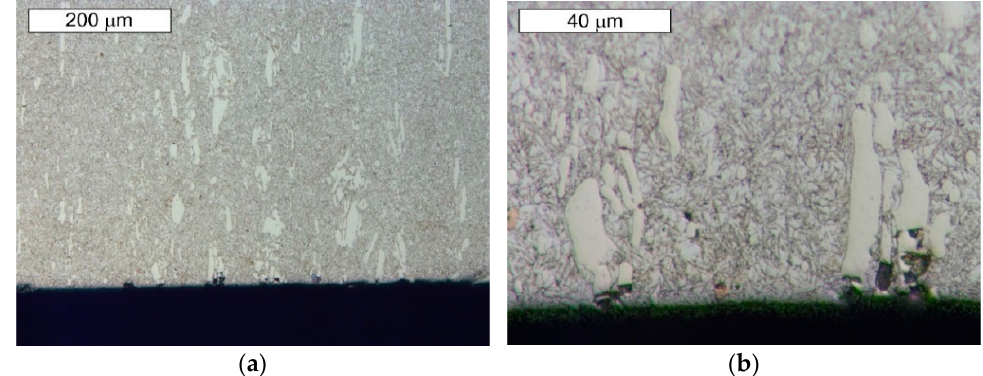
Figure 14. Material microstructure in the wear area of sample 1: ( a ) visible small spallings in the primary carbide area; ( b ) magnified fragment of the area from Figure 14a. Cross-section. Light microscopy, etched state.